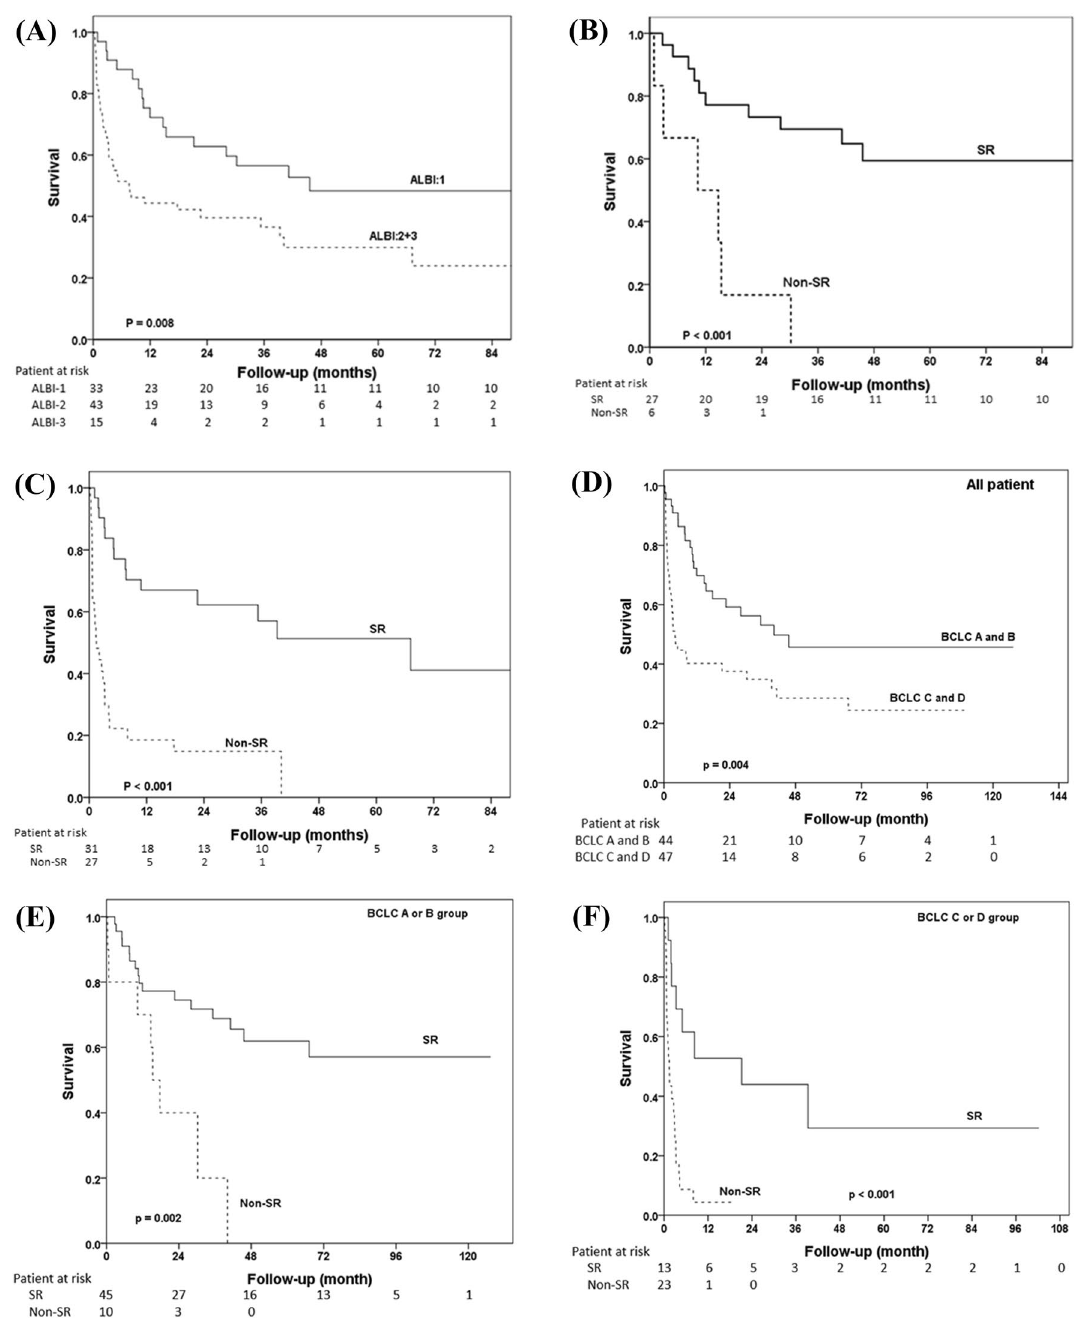
Figure 3. Comparison of OS rates between SR and non-SR groups stratified by ALBI grade and BCLC stages ( A ) Comparison of OS rates between patients with ALBI grade 1 and those with grade 2 or 3. ( B ) Comparison of OS rates between SR and non-SR groups in patients with ALBI grade 1. ( C ) Comparison of OS rates between SR and non-SR groups in patients with ALBI grade 2 or 3. ( D ) Comparison of OS rates between patients with BCLC stage A or B and those with BCLC stage C or D. ( E ) Comparison of OS rates between SR and non-SR groups in patients with BCLC stage A or B. ( F ) Comparison of OS rates between SR and non-SR groups in patients with BCLC stage C or